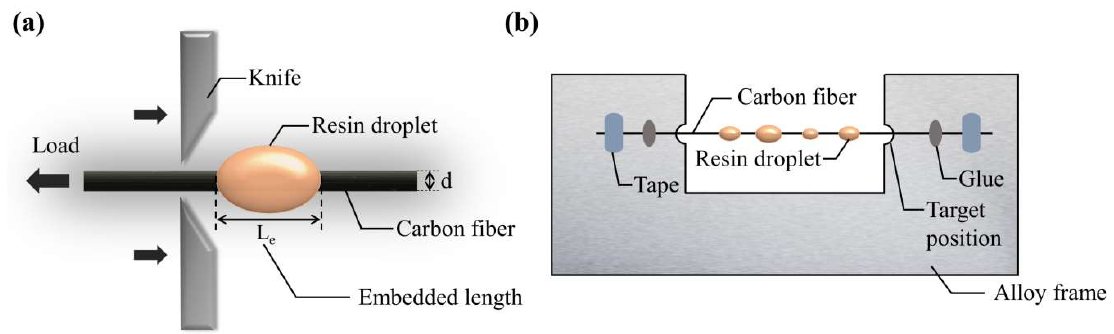
Figure 3. Illustrations for the microdroplet test: ( a ) the process of microdroplet test, ( b ) the scheme of the sample.